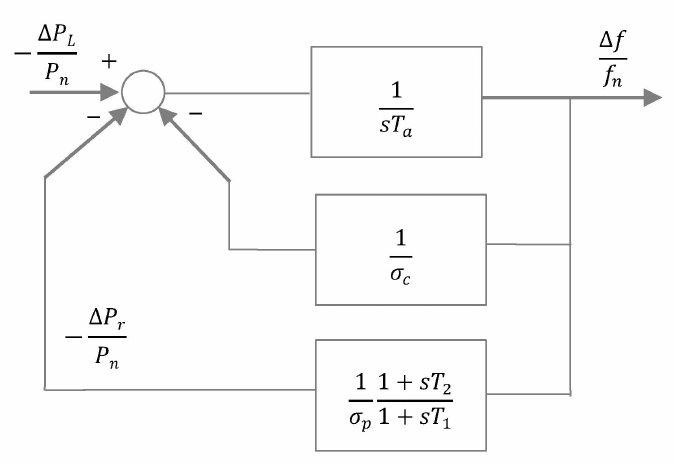
Figure 1. Block diagram for analyzing the frequency